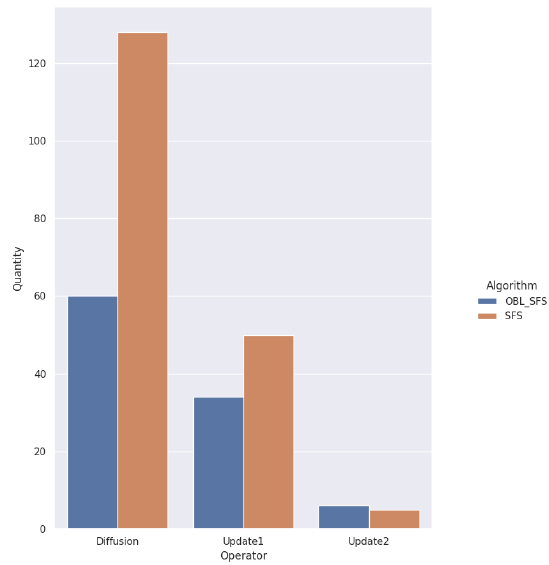
Figure 5. Effective operators.